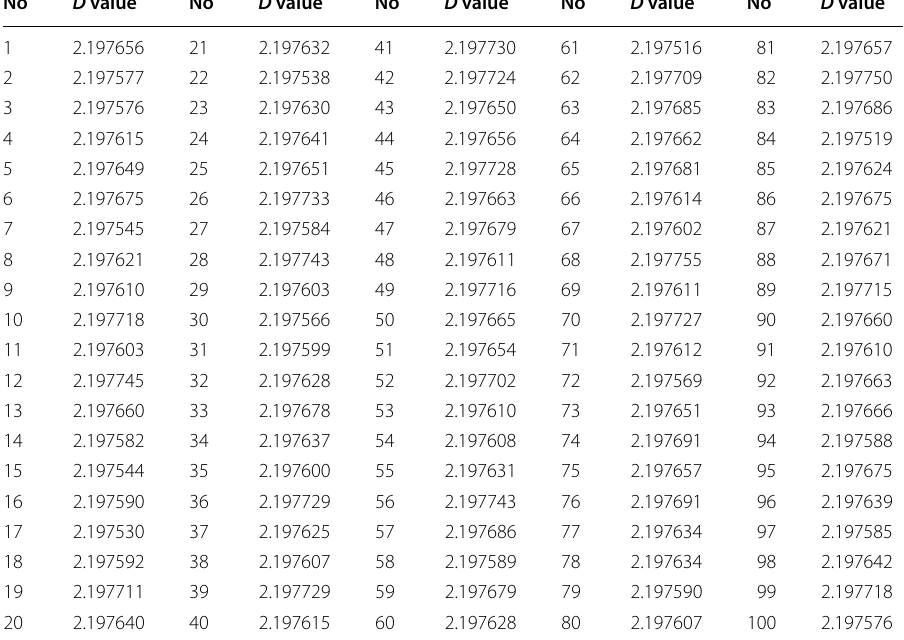
Table 1 100 Samples of fractal dimensions of the synthetic surfaces